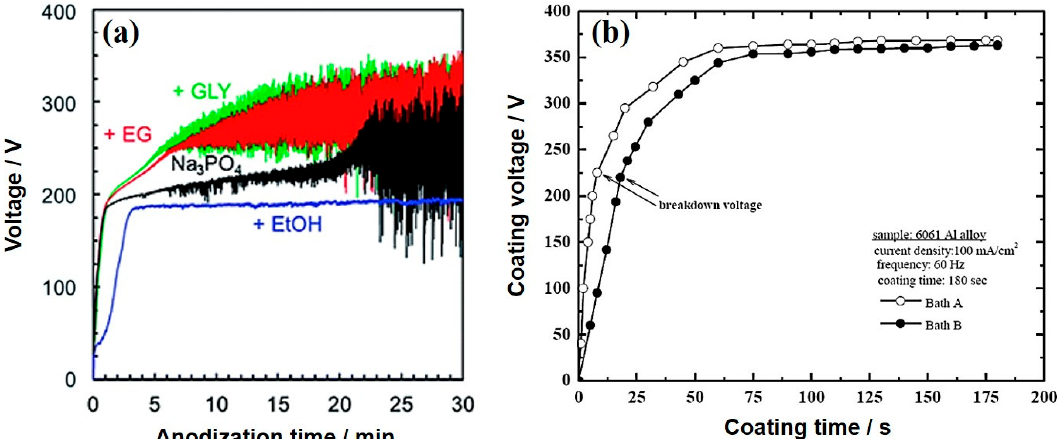
Figure 1. ( a ) Voltage-time curves of AZ31 Mg alloy coated via plasma electrolytic oxidation (PEO) in electrolytes without and with organic additives, such as ethanol (EtOH), ethylene glycol (EG), and glycerol (GLY). [46] ( b ) Voltage-time curves of 6061 Al alloy coated in the electrolytes without and with NaBz. Reprinted from permission from [47]. Copyright 2015 Elsevier